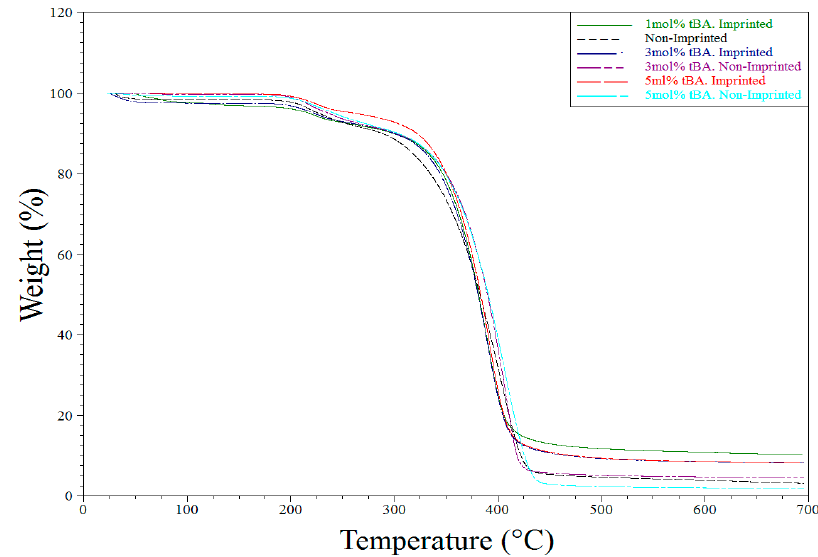
Figure 8. TGA degradation of all polymers synthesized for the variable tBA study.